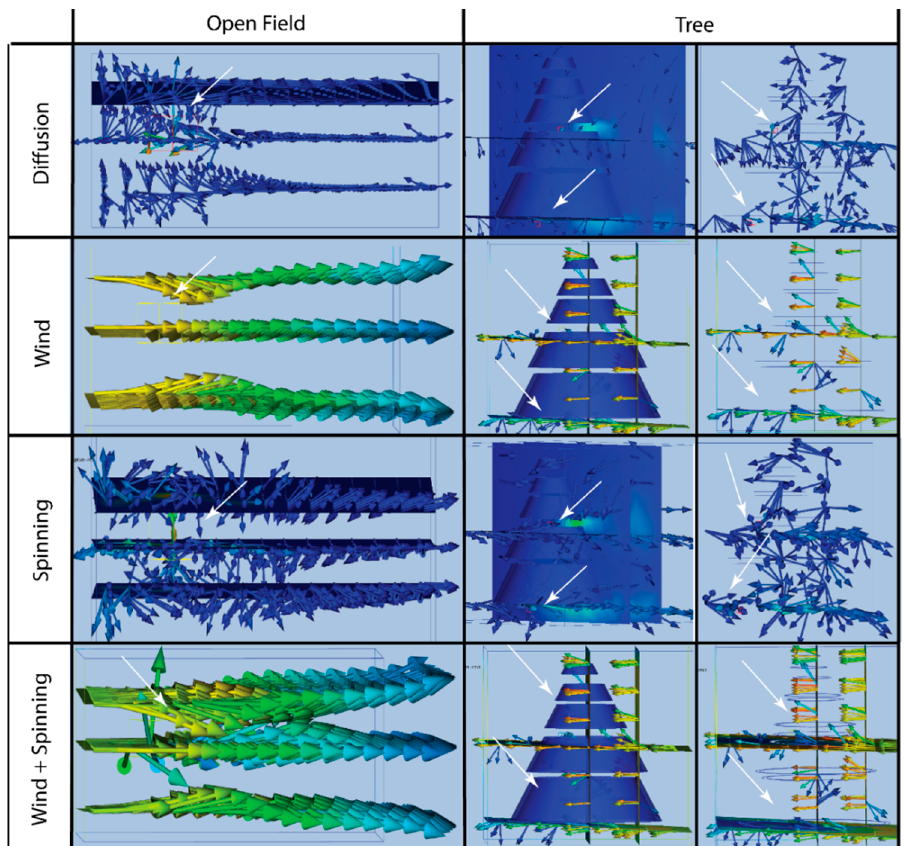
Figure 6. Pheromone Airflow—velocity field results of open field and tree conditions. Each image shows the Autodesk CFD velocity vector results. Air velocities are coded by a color gradient where blue is slower, and red is faster (colors are relative within each test). White arrows show the location of the spider in each test, one in the field and two in the tree. The tree tests are shown with the full tree structure and with only an outline of the tree to view airflow within the tree more easily. Open field conditions—The open field shows how diffusion creates minimal velocity around the spider. The spinning creates a larger velocity but mostly creates turbulence around the spider which continues further downstream. The wind has the largest effect on airflow. It slows down slightly as it passes through the nearly stagnant pheromone cloud, but the stream remains laminar and independent. When spinning is added to the wind, the velocity in front of the spider is increased. The normally straight trail of pheromones is instead mixed up and down being carried by the wind in now multiple directions, further distributing the pheromones over the open landscape. Tree conditions—The various barriers and openings within the tree innately create pockets of higher and lower-density air as the wind blows past it. The wind is pulled through the tree, swirling around, before being pulled out the opposite side. The highest flow velocities are surrounding the tree and exiting the tree downwind. The structure of a tree allows pheromones to be distributed throughout a tree more easily and naturally. Pheromones fill the tree and then leak from it, creating a beacon. The velocities within the tree fall when the spider bounces, slowing down the air flow in the